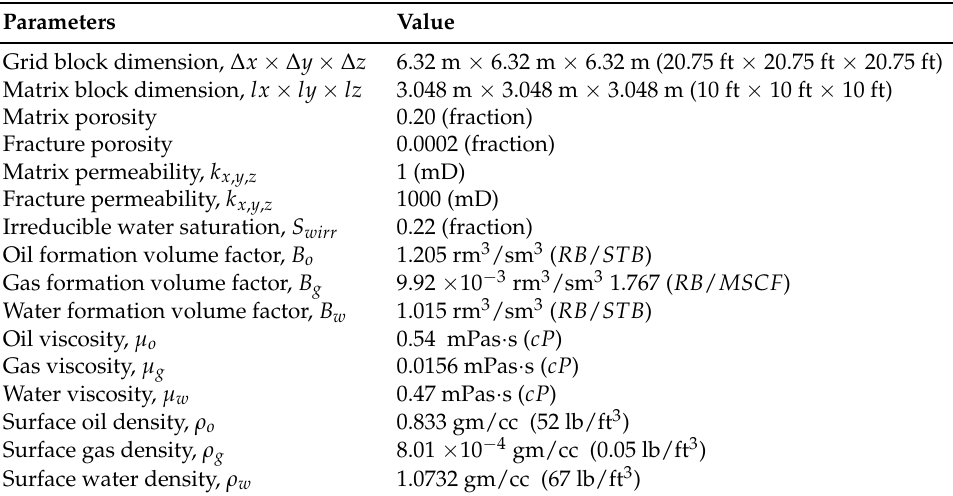
Table 2. Rock and Fluid properties of the fine-scale model.